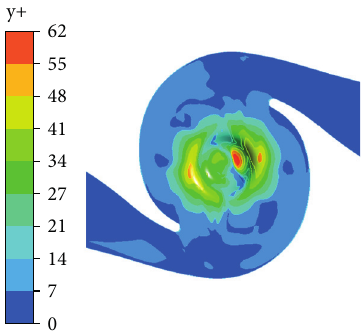
Figure 5: Distribution of y +on the surface of